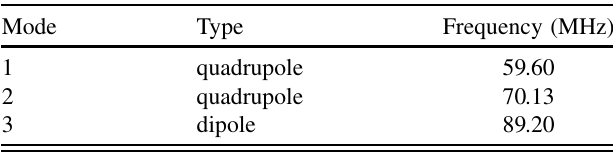
TABLE XIV. Types and frequencies of the first 3 RFQ modes calculated without including the vane modulation.